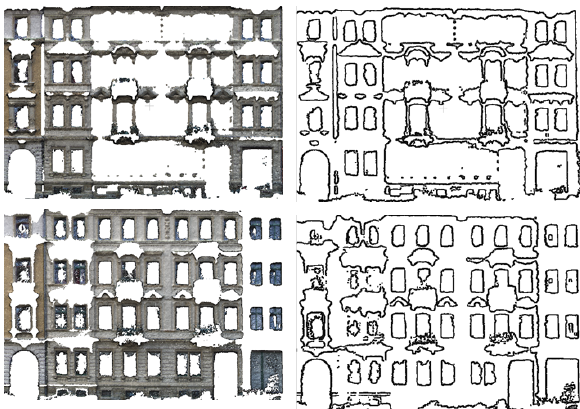
Figure 1: Block diagram of the complete algorithmic work flow. An optional clustering is used to divide the search space to enable a parallel implementation. Also the fusion of surface curvature values is optional and only needed for facades whereby, windows and doors are only slightly off the main facade plane thus providing little 3D geometrical information. This can be found particularly in some modern buildings.